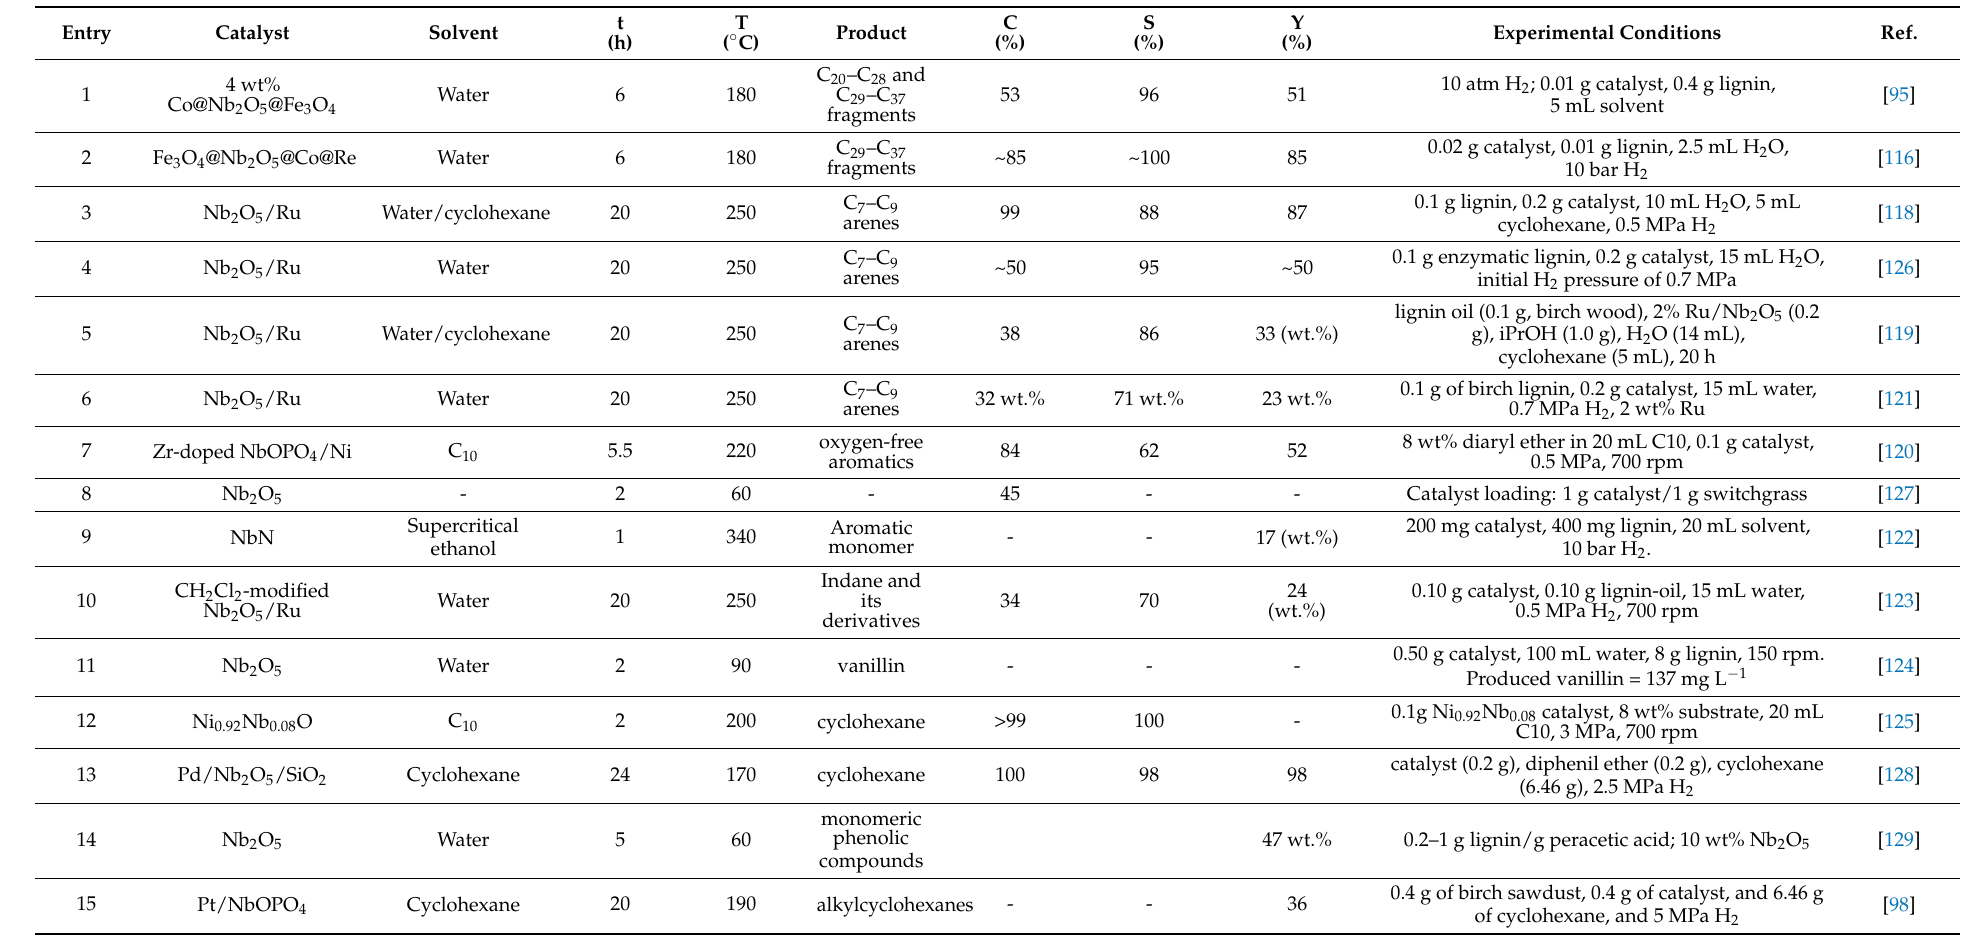
Table 3. Performance of niobium-based catalysts for conversion of lignin into different products—from 2010 up to